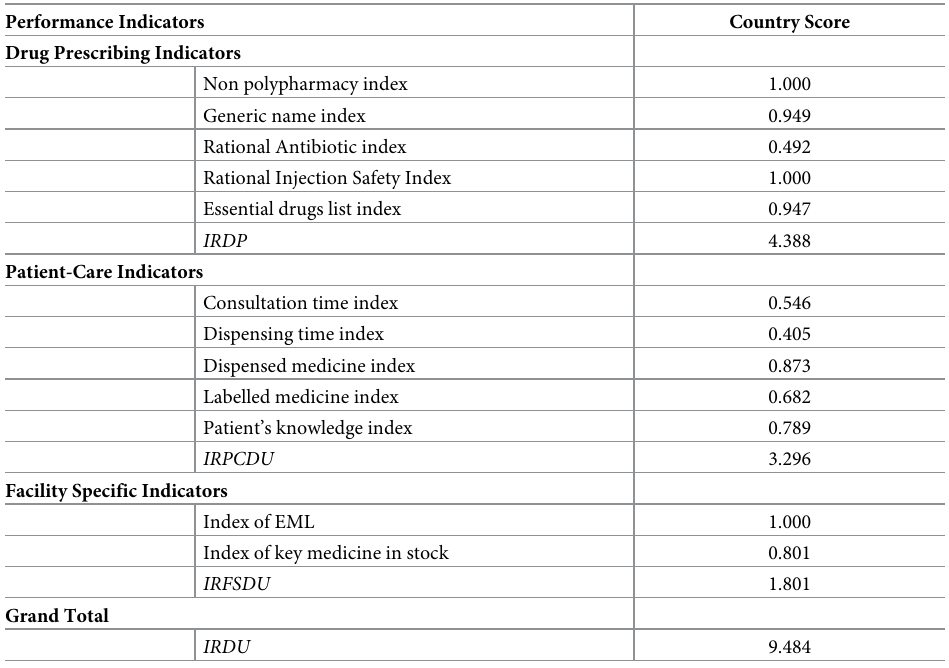
Table 8. Country performance